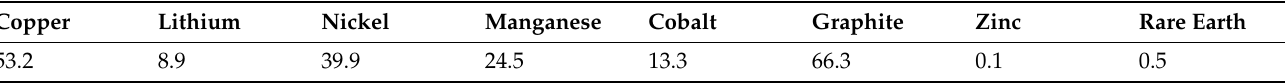
Table 5. Mineral resource consumption in the electric vehicle industry (Unit: kg/vehicle) (Data Source: